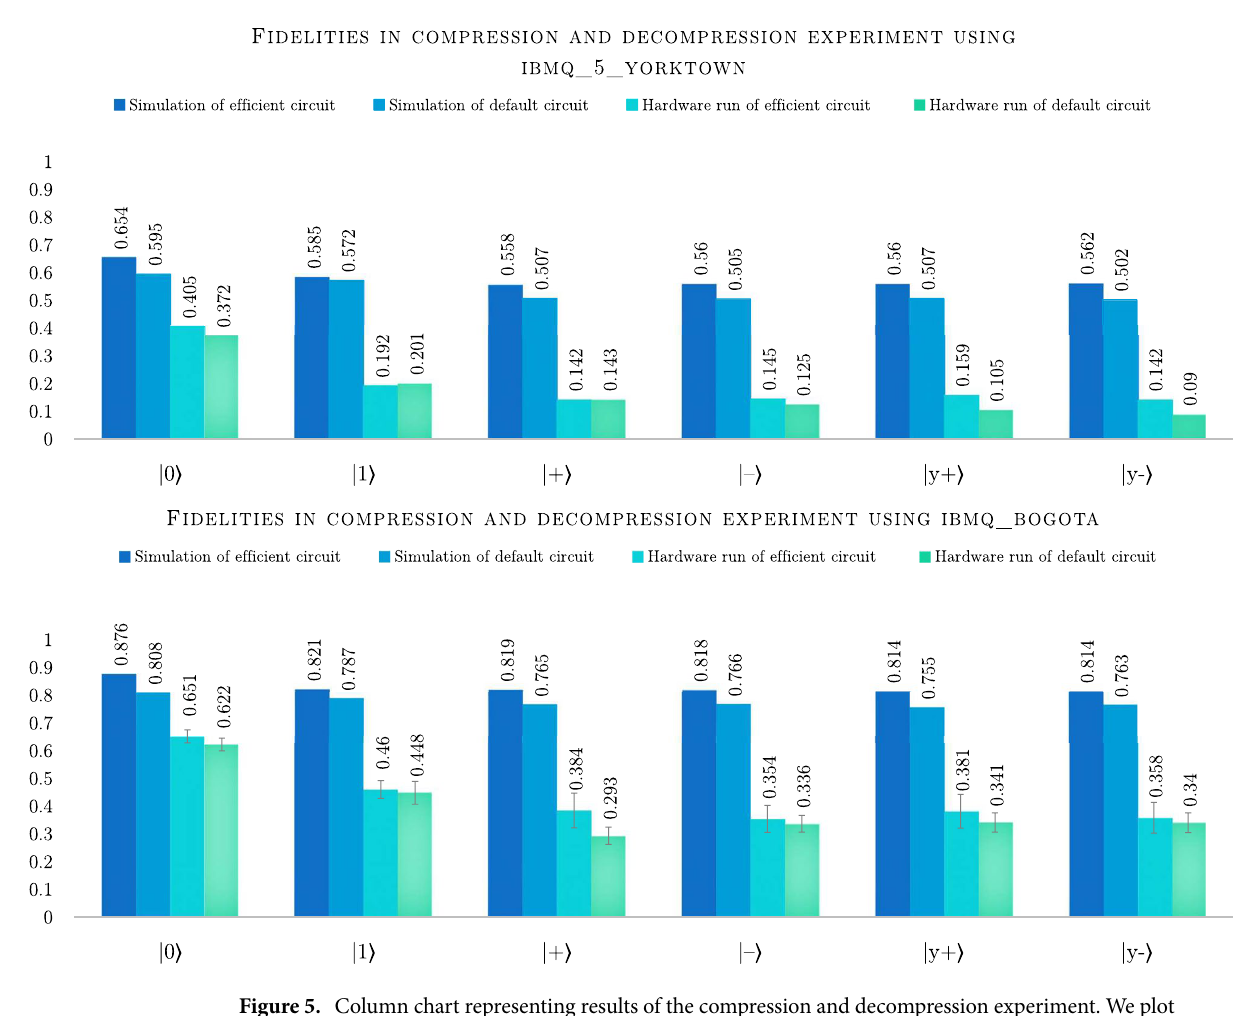
Figure 5. Column chart representing results of the compression and decompression experiment. We plot ψ ⊗ 3 ψ the fidelity of the decompressed states to , where is the input state. Simulations were performed with | � | � 1 million shots each, using error parameters provided by IBM for each of the hardware backends ( ibmq_5_ yorktown and ibmq_bogota ). Due to the expected low fidelity on ibmq_5_yorktown , the experiments were run only once with 8192 shots. On the other hand, in case of hardware run on ibmq_bogota we present averages calculated over 10 runs with 8192 shots each. We use standard deviation for error